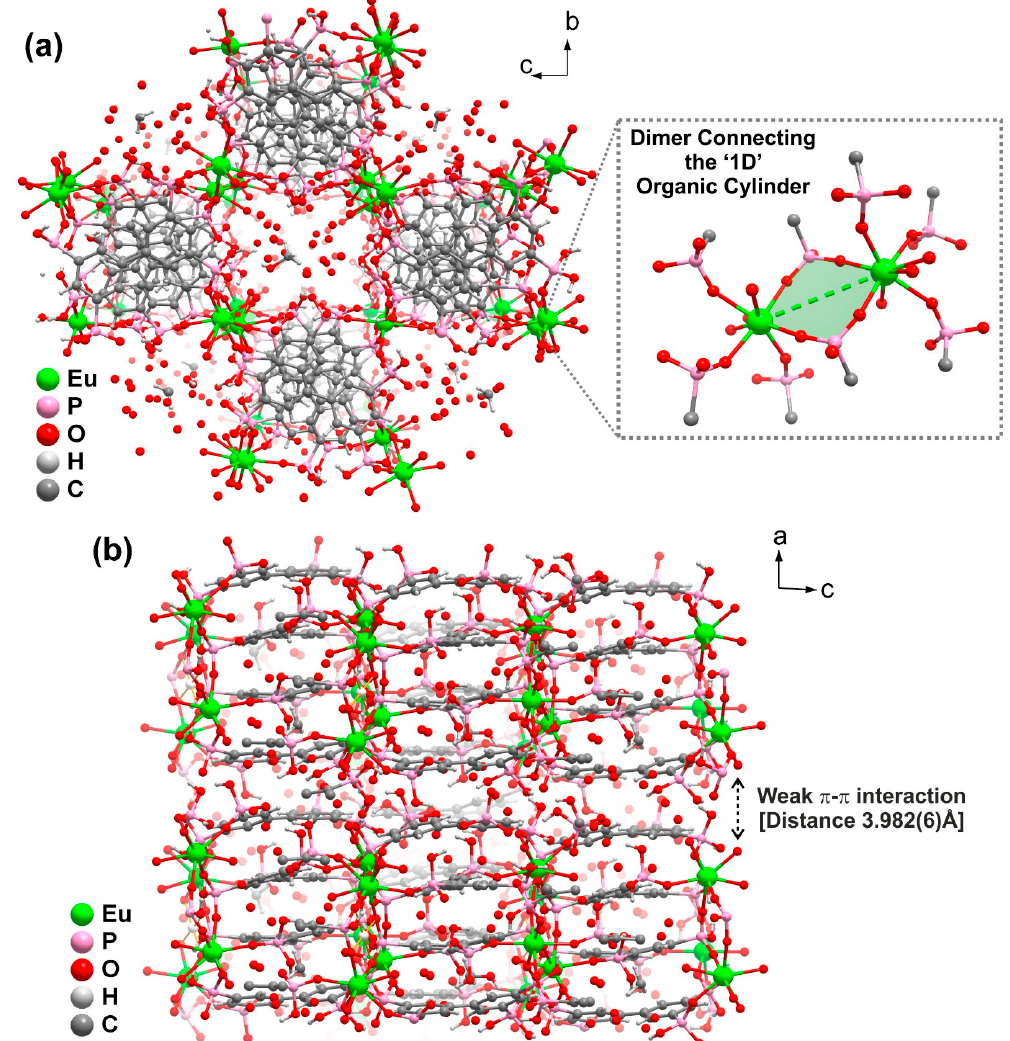
Figure 2. Crystal packing of [Eu 7 (H 5 btp) 4 (H 5.5 btp) 2 (H 6 btp) 2 (H 2 O) 12 ] ∙ 23.5H 2 O ∙ MeOH ( 1Eu ) viewed in perspective along the ( a ) [100] and ( b ) [010] directions of the unit cell. The representations emphasize simultaneously the presence of several dimmers formed by the metal centers and the phosphonic acid groups that connects the “1D” organic cylinders of 1Eu .